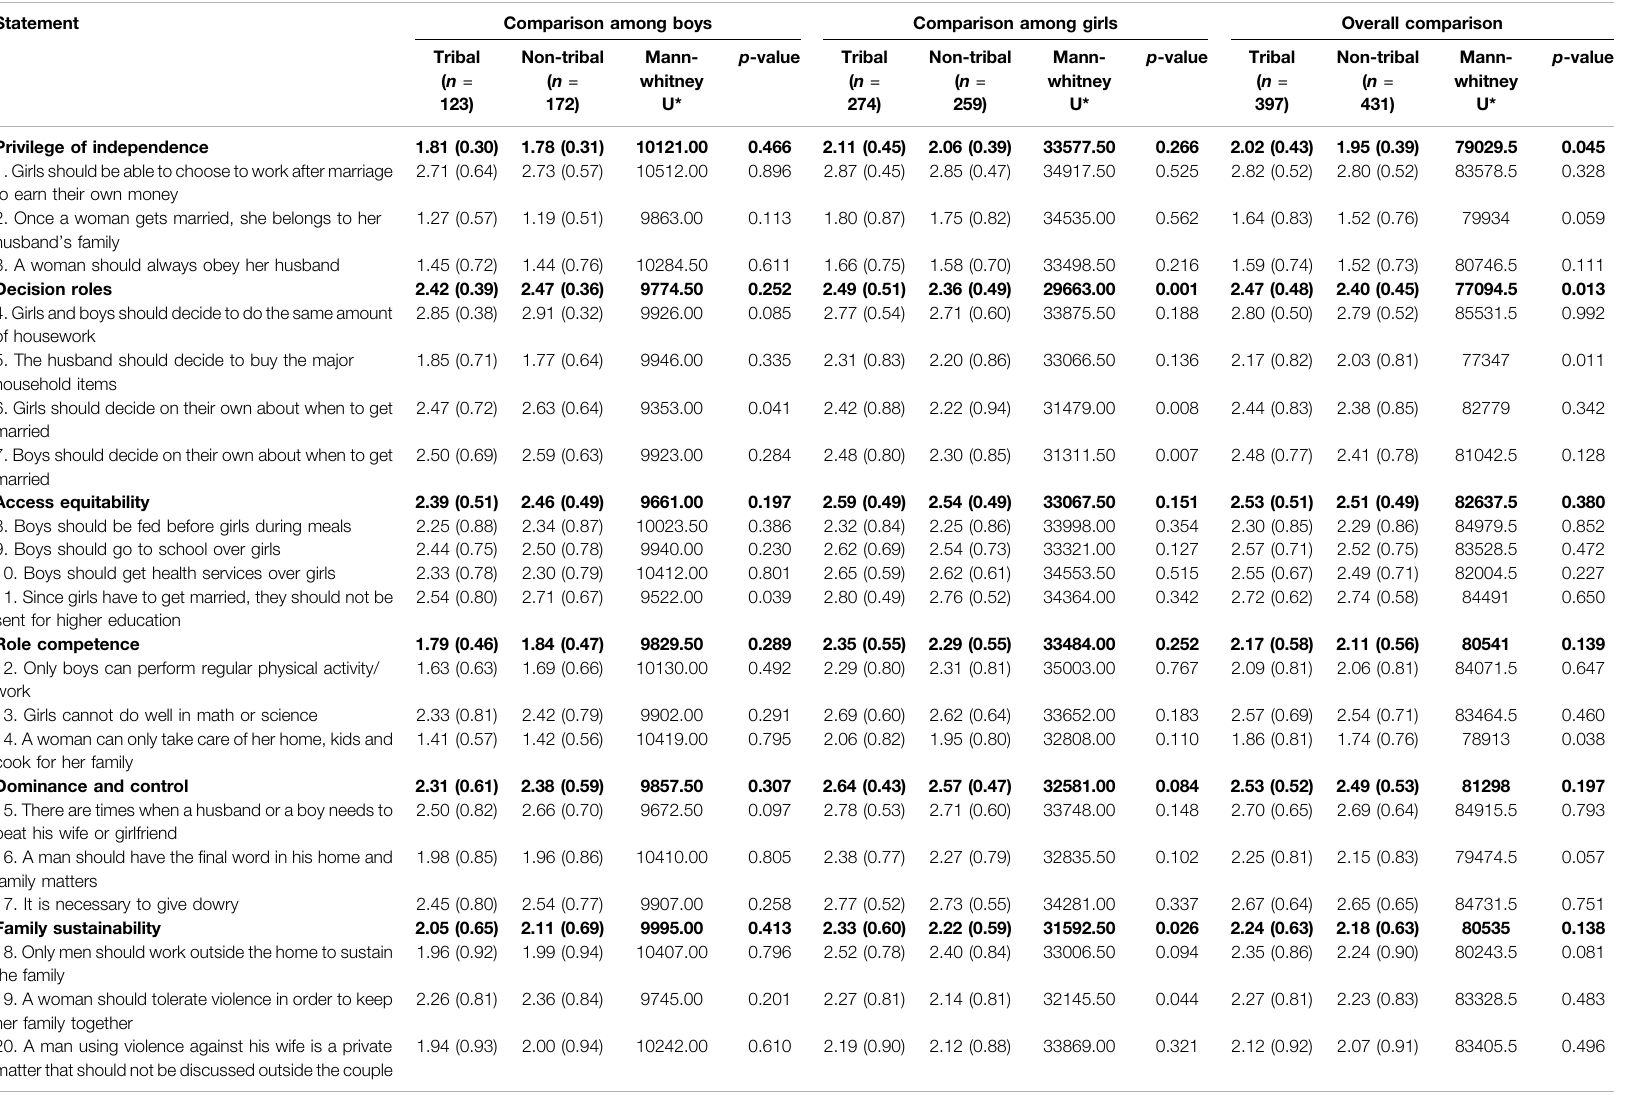
Values within the parentheses represent standard deviation corresponding to the mean value presented outside the parentheses. p -values were calculated by Mann-Whitney U test. *Denotes the test statistic observed in each test. The numbers in bold represent the overall effect of these each